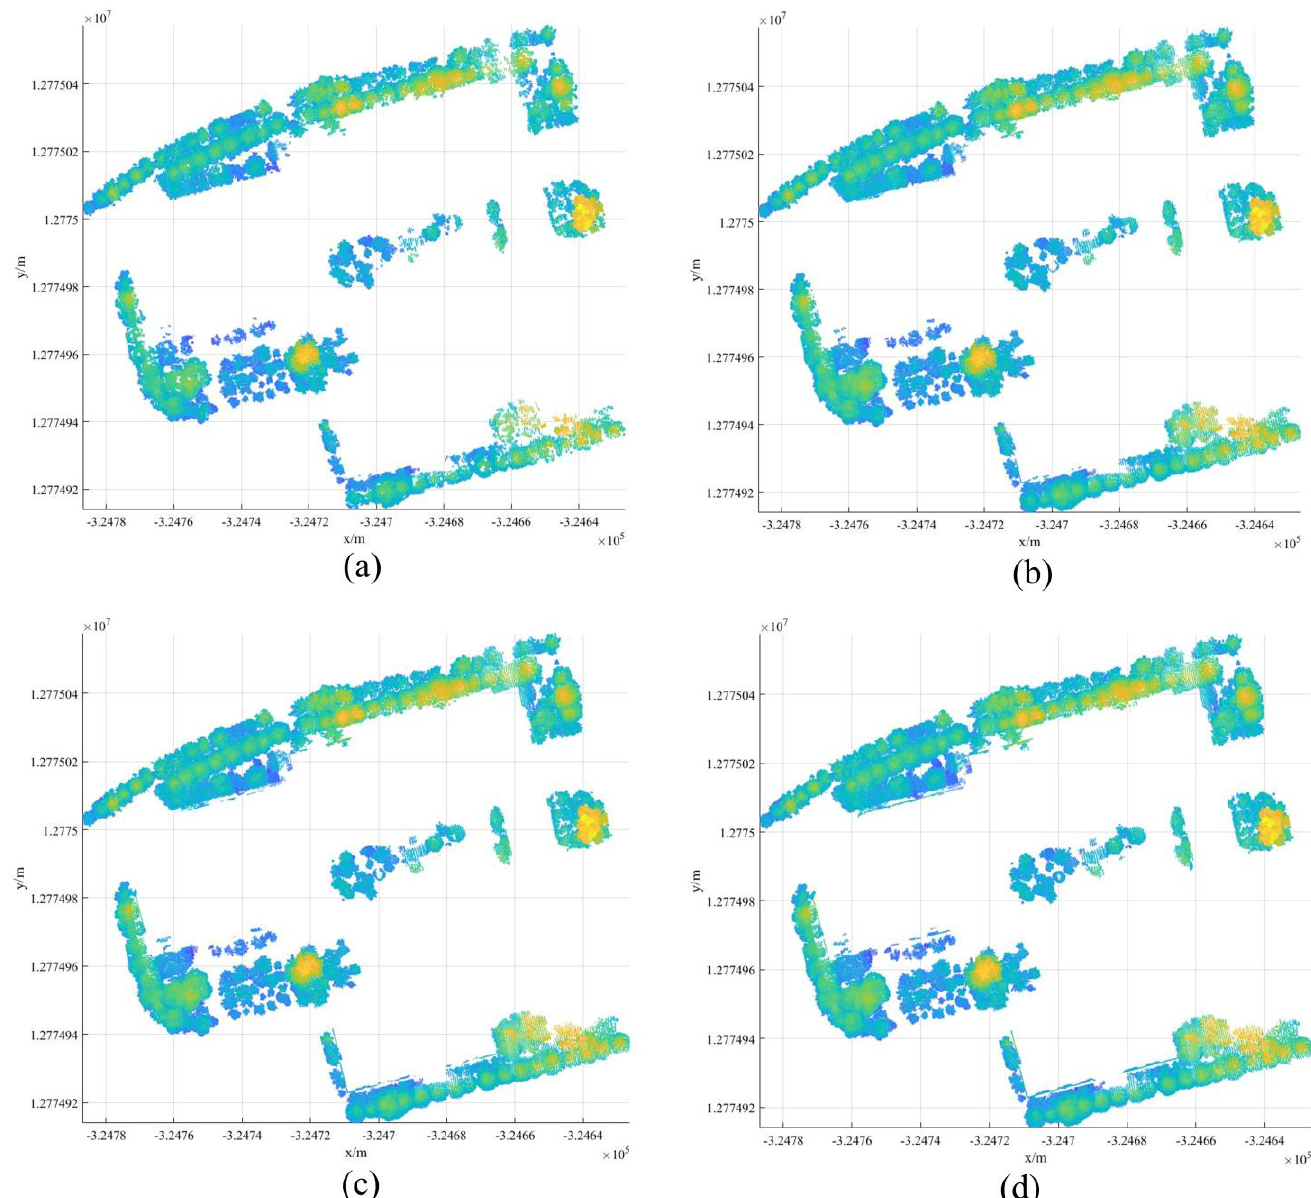
Figure 12. Vegetation extraction results of plot 2 at different r scales. ( a ) r = 0.5 m; ( b ) r = 1 m; ( c ) r = 1.5 m; ( d ) r = 2 m. Table 2. The recall and precision evaluation results of plot 2.